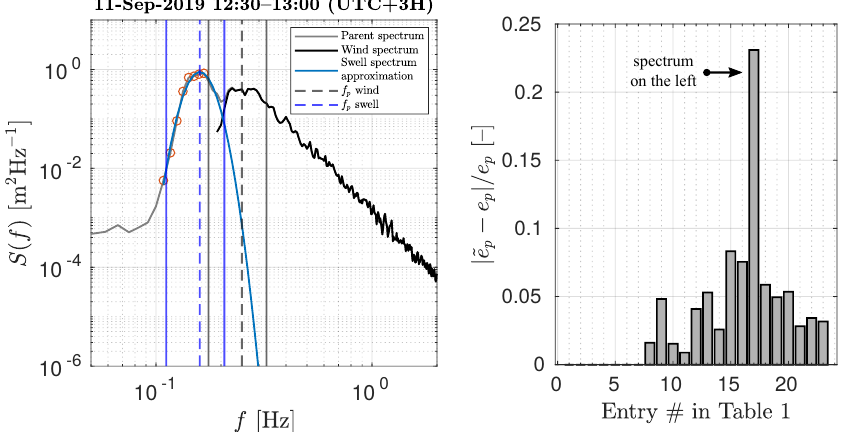
Figure A1. ( left ) An example of swell and wind-wave systems separation in the frequency domain. The spectrum is from the upper left Figure 2. Orange circles show points used in the polynomial fit in the log-log domain. ( right ) Relative change in the energy of wind-waves after